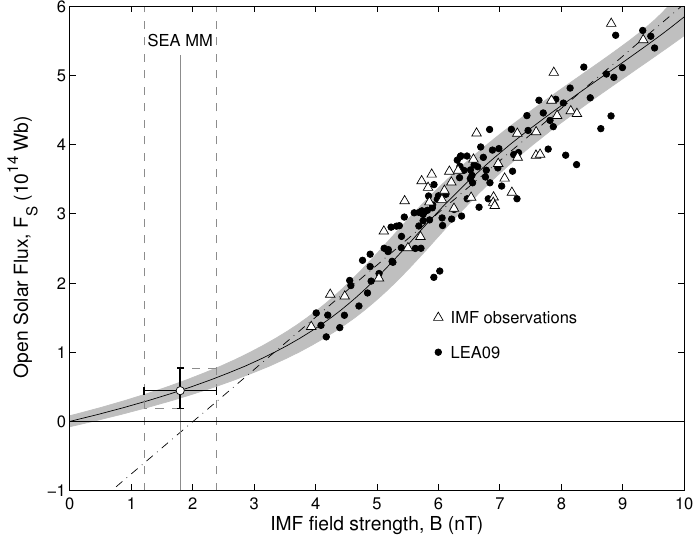
Figure 29: Scatter plot of open solar flux 𝐹 𝑆 as a function of near-Earth IMF field strength, 𝐵 . The solid points are from the LEA09 reconstruction and the open triangles are annual means from in-situ interplanetary data (with 𝐹 𝑆 computed using Equation (8) with T = 1 h and the kinematic correction for Δ 𝐹 𝑆 ). The black line is a polynomial fit to both datasets, constrained to pass through the origin ( 𝐵, 𝐹 𝑆 ) = (0 , 0), with an uncertainty given by the grey area. The dot-dash line is a linear regression fit. The vertical solid line labelled SEA MM shows the value of 𝐵 during the Maunder minimum derived using cosmogenic isotopes by Steinhilber et al. (2010) and the vertical dashed lines bound the uncertainty in that estimate. Image reproduced by permission from Lockwood and Owens (2011), copyright by